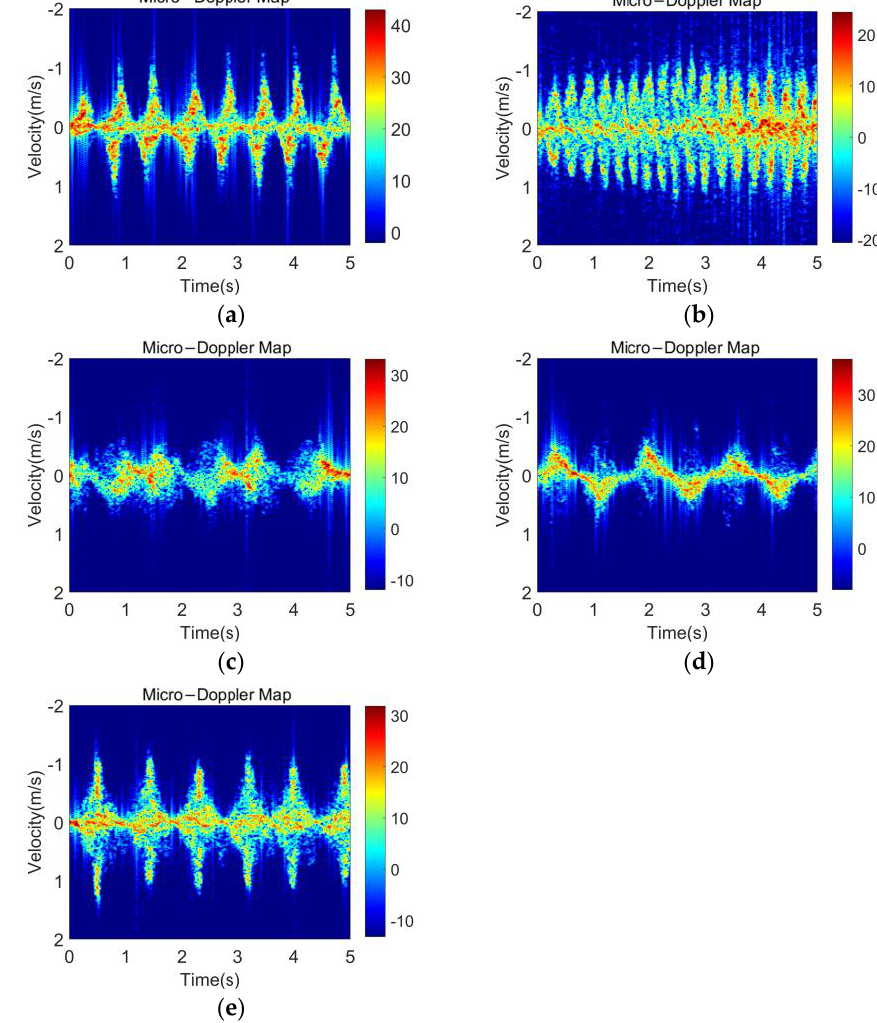
Figure 6. MDM after the average cancellation of five activities: ( a ) walking; ( b ) running; ( c ) standing up after squatting down; ( d ) bending; and ( e ) turning.